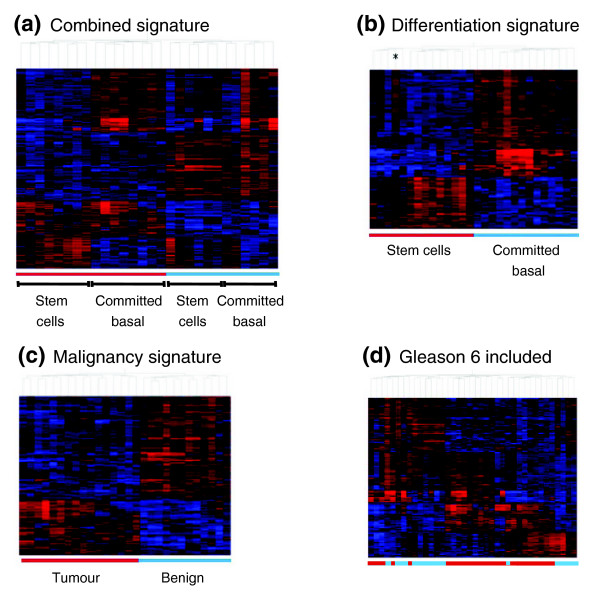
Distinctive stem cell and tumor signatures are found in human prostate cancers containing a minimum Gleason score 7 pathology. Clustering analysis (derived from the Pearson correlation) using the expression data for the probesets (from 28 samples) define a cancer stem cell signature. Blue tiles indicate down-regulated genes, and red tiles indicate up-regulated genes. (a) The combined signature clustered samples as benign (blue bar) and malignant (red bar). Cell type (stem, CD133+/α2β1hi; and committed, CD133-/α2β1low) was also defined within each disease state. (b) The differentiation signature. One sample in which a clear differentiation signature 'breakthrough' was evident in the combined signature is indicted by an asterisk. (c) Sample clustering according to the malignancy signature. (d) Hierarchical clustering with the Gleason 6 samples and a single hormone treated sample included in the analysis. Note that the clear distinction between non-malignant and malignant biopsies is lost by including this data.